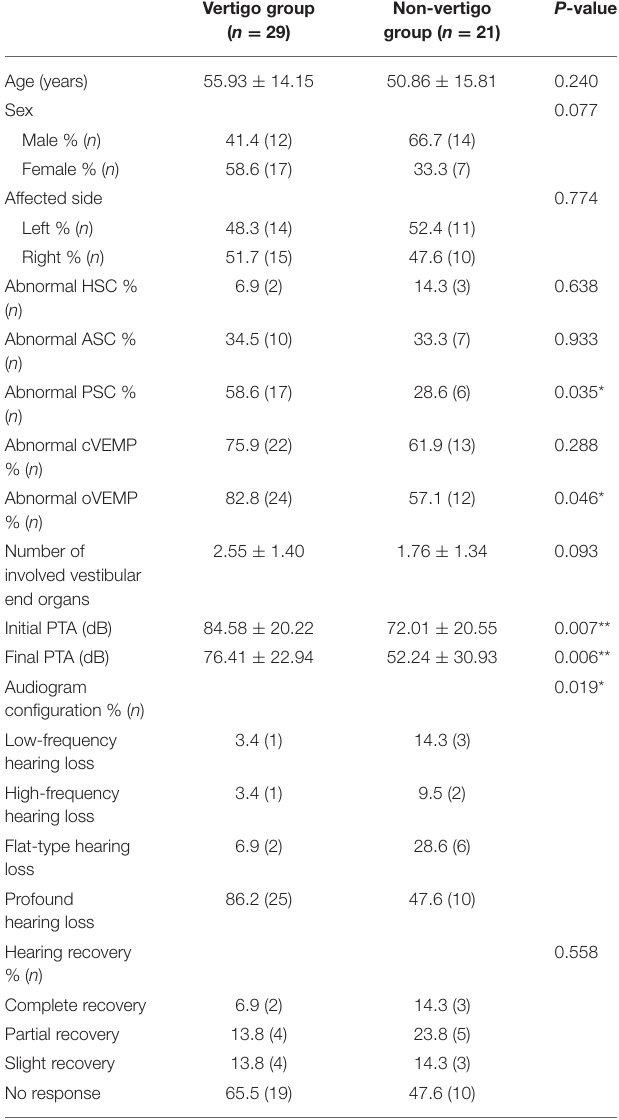
TABLE 1 | The clinical data and audio-vestibular tests of the vertigo group and non-vertigo